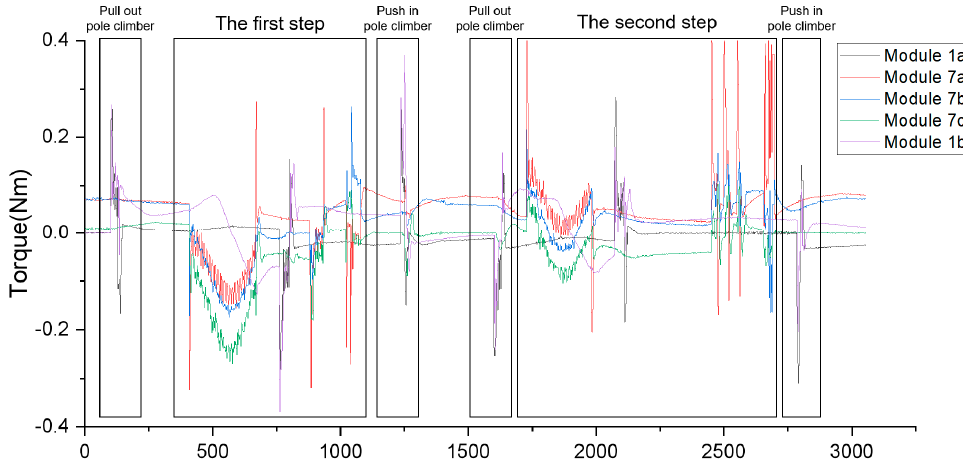
Figure 15. Motor torque waveforms of turning-over gait.